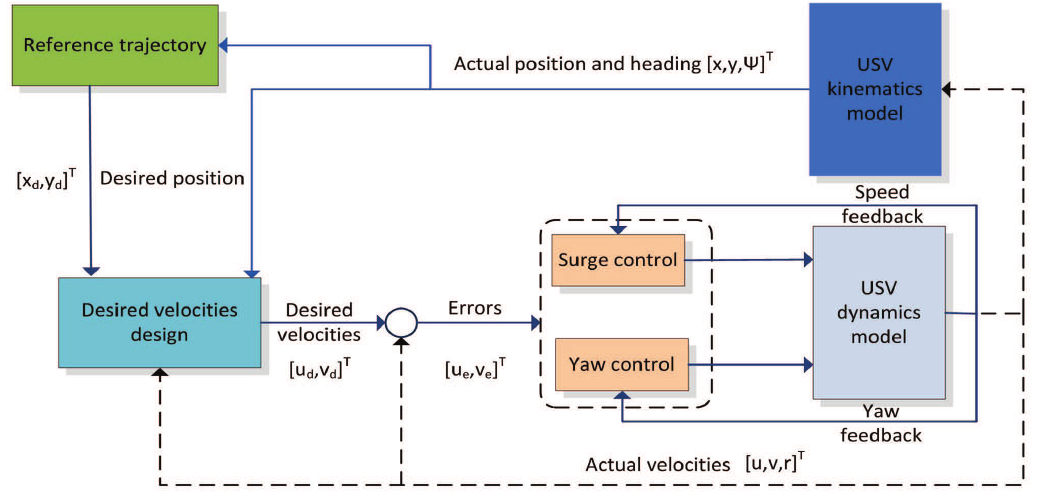
Figure 2. Block diagram of trajectory tracking control